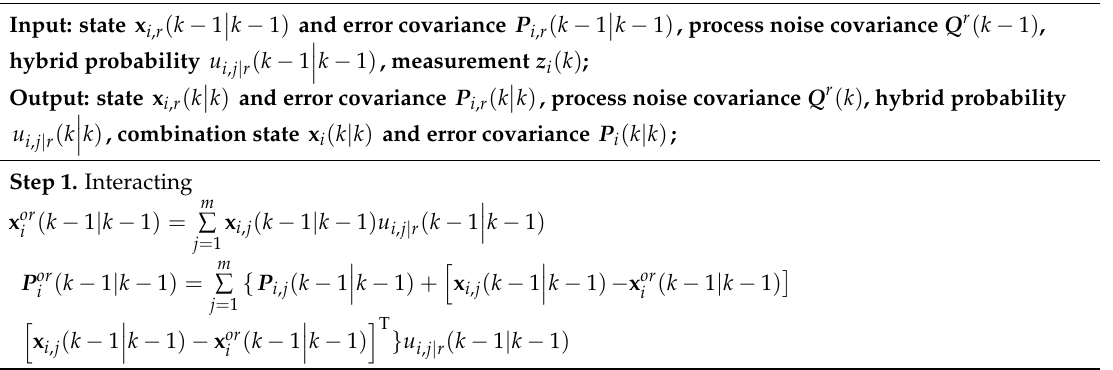
Algorithm 1. IMAM-UICF for sensor i at time instant k